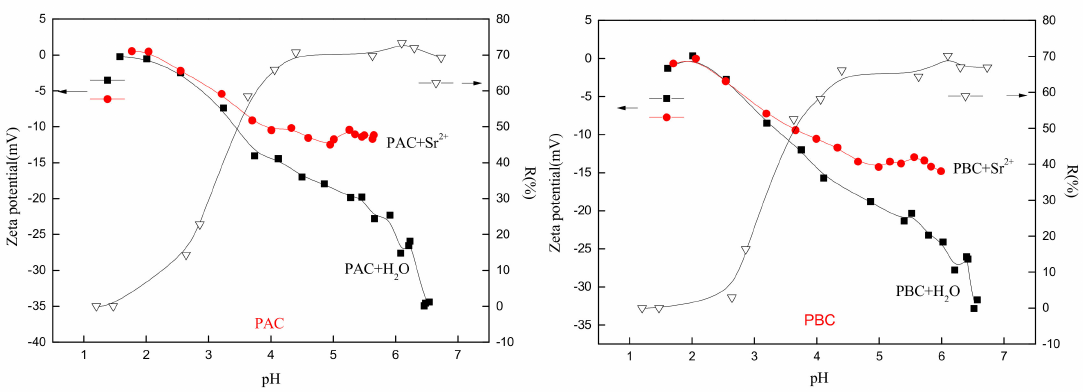
Figure 6. E ff ect of pH on Sr adsorption and zeta potential of adaxial (PAC) and abaxial (PBC) cuticle with and without Sr